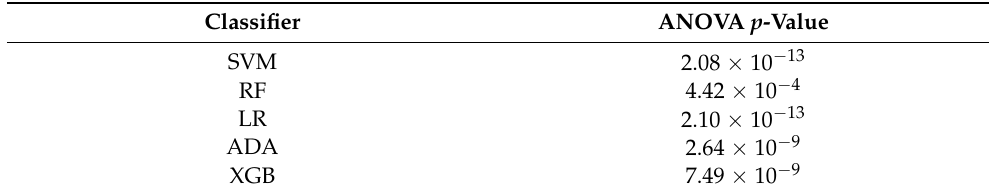
Table 3. One-way ANOVA results for each